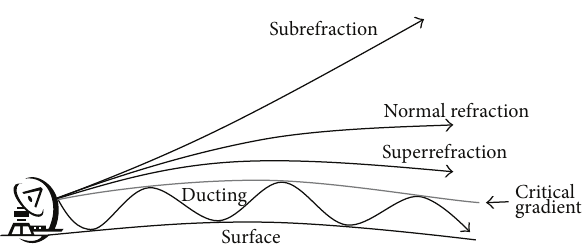
Figure 3: Occurrence principle of anomalous propagation echo.